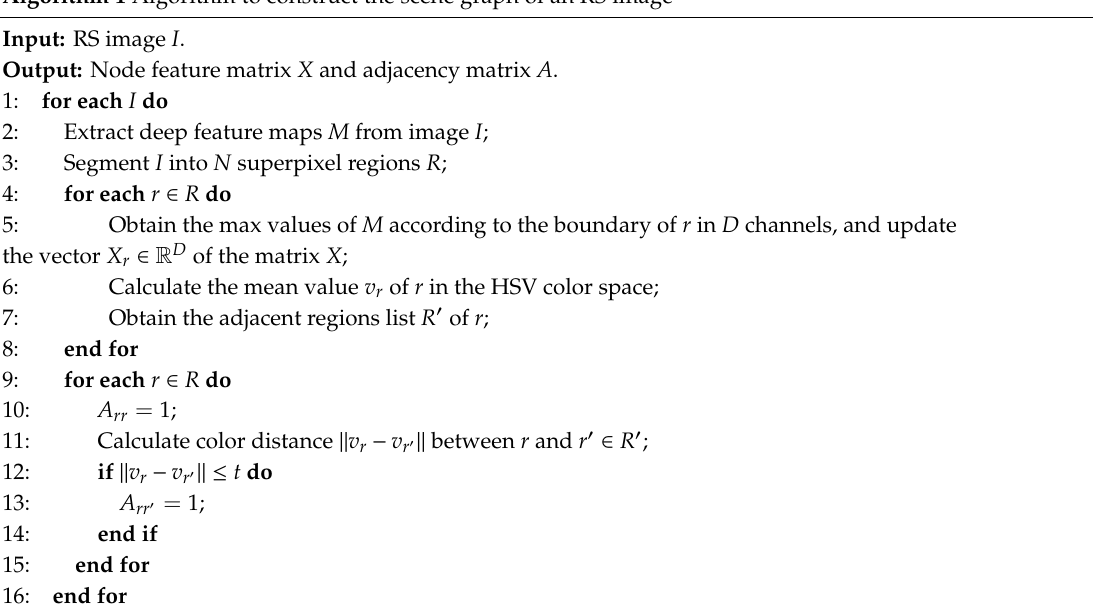
Algorithm 1 Algorithm to construct the scene graph of an RS